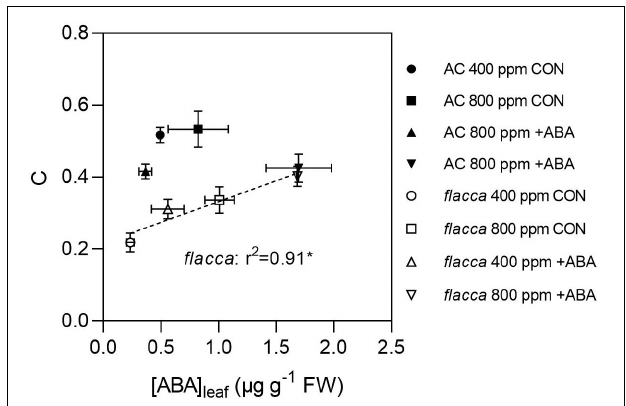
FIGURE 6 | Relationship between the FTSW threshold at which g s started to decline (C) and the leaf ABA concentrations ([ABA] leaf ) at second harvest before FTSW reaching C in AC and flacca grown under ambient (400 ppm) and elevated (800 ppm) CO 2 concentrations. CON indicates the control treatment sprayed with water, +ABA indicates exogenous ABA application. * Indicate significant difference of the regression line of flacca at p < 0.05. Error bars indicate the standard error of the means (S.E.) ( N =